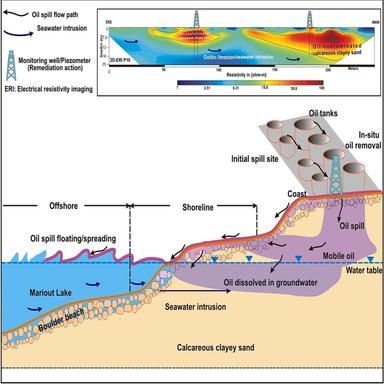
A Simulation model for a better understanding of the oil spillage representing the proposed remediation action along the coastal zone.